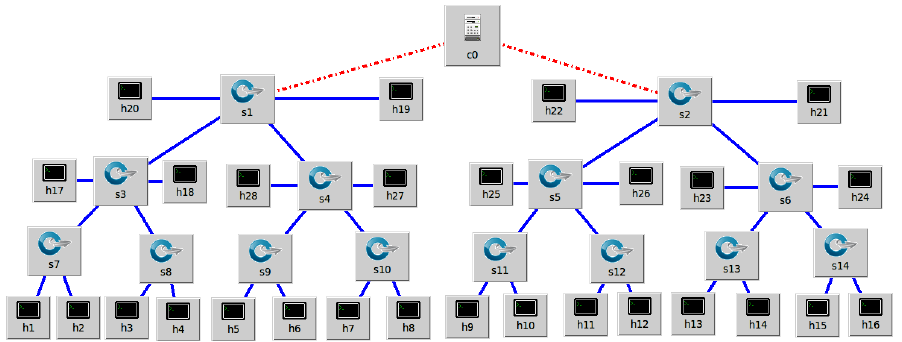
Figure 2. Custom SDN-enabled IoT network topology with POX